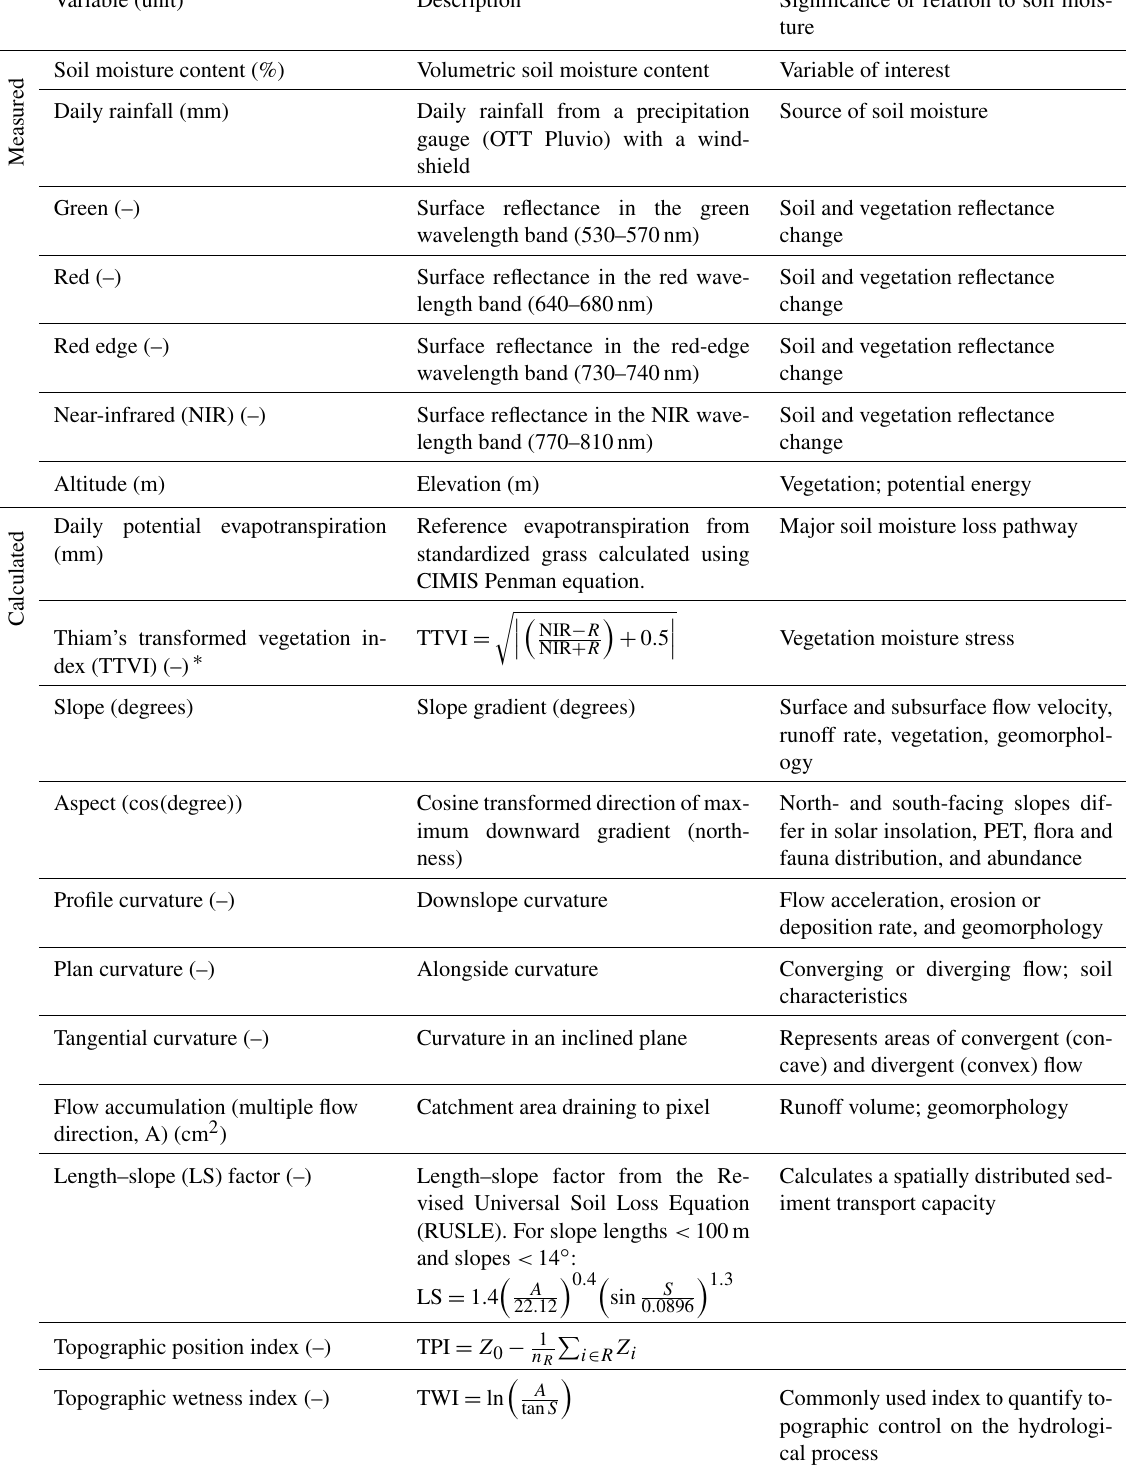
Table 1. Measured and calculated data used for machine learning. All topographic variables are computed from the digital elevation model. Descriptions and significance of topographic variables are adapted from Wilson and Gallant